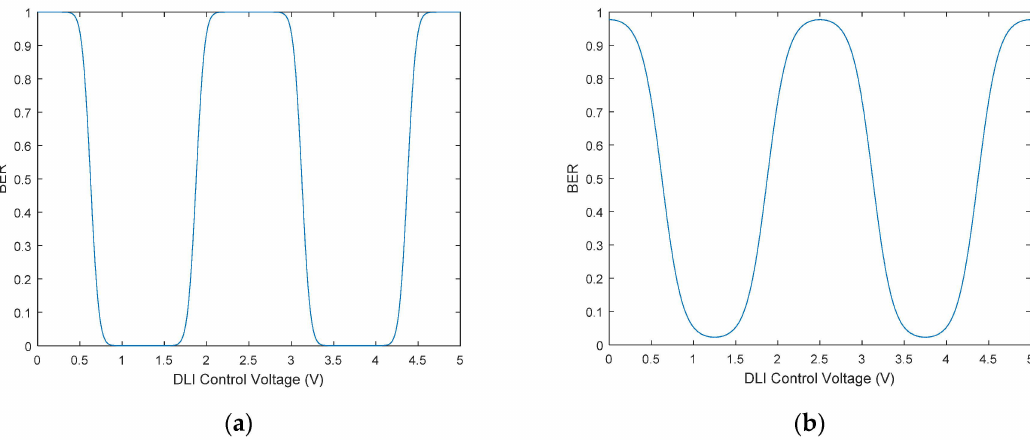
Figure 5. Simulated BER curve while DLI control voltage is increasing: ( a ) represents the cases with a high OSNR; ( b ) represents the cases with a low